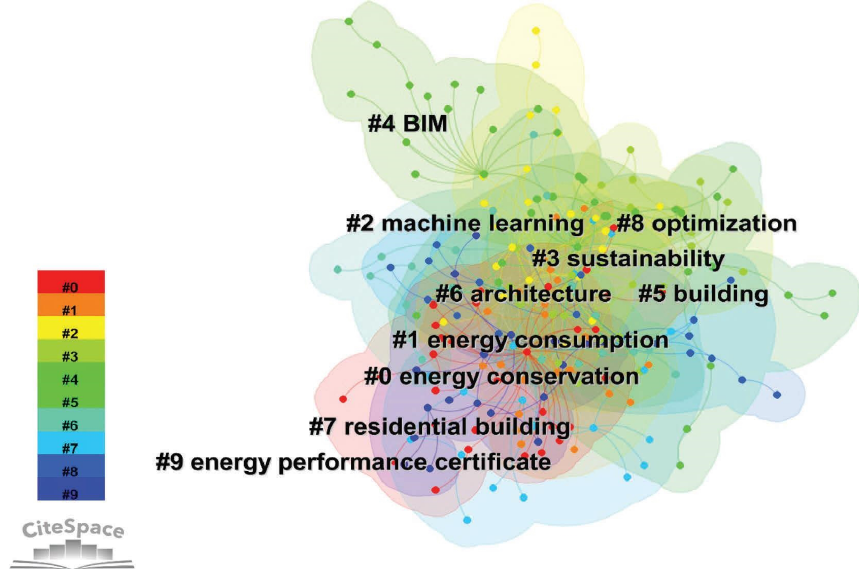
Figure 6: Keyword clustering map.